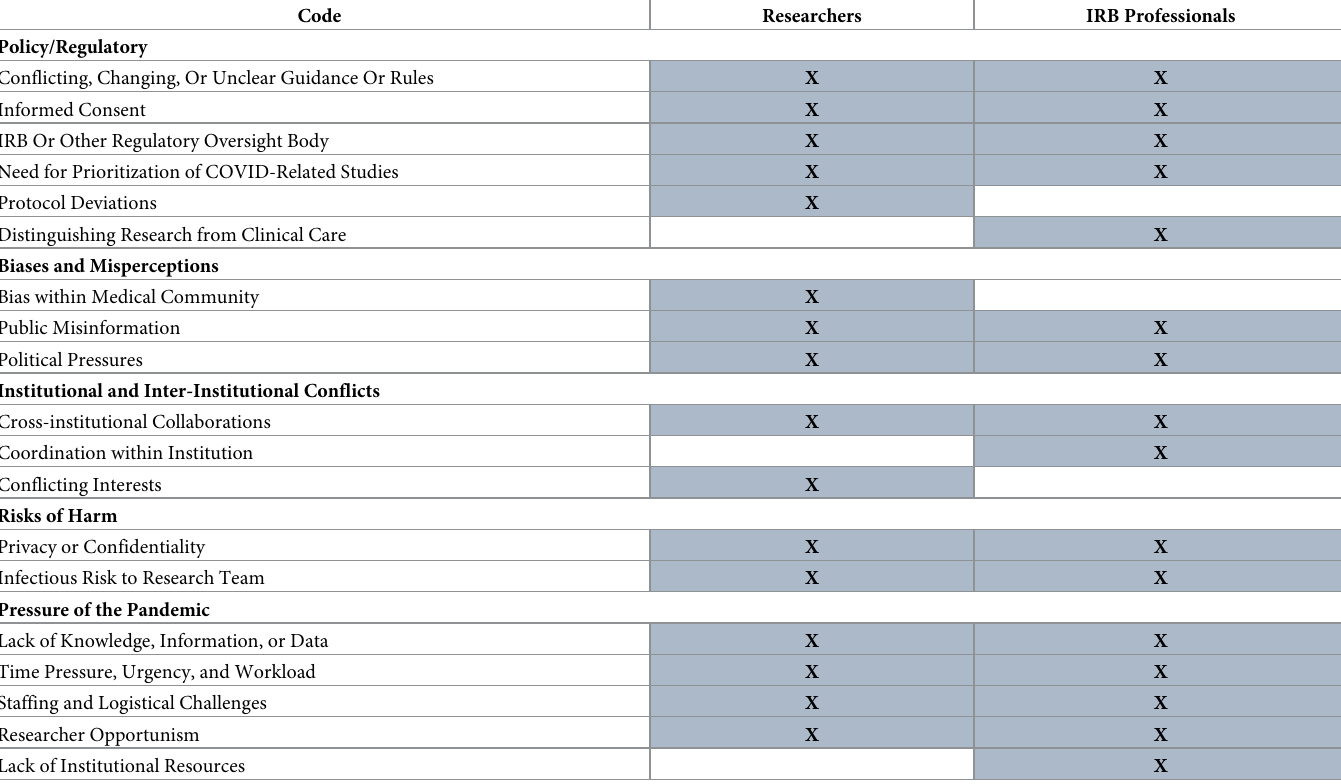
Table 2. Identification of challenges and